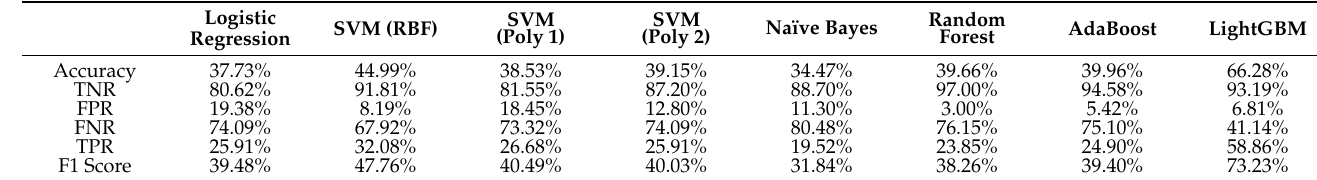
Table 3. Performance of the tested models on the evasive validation data.